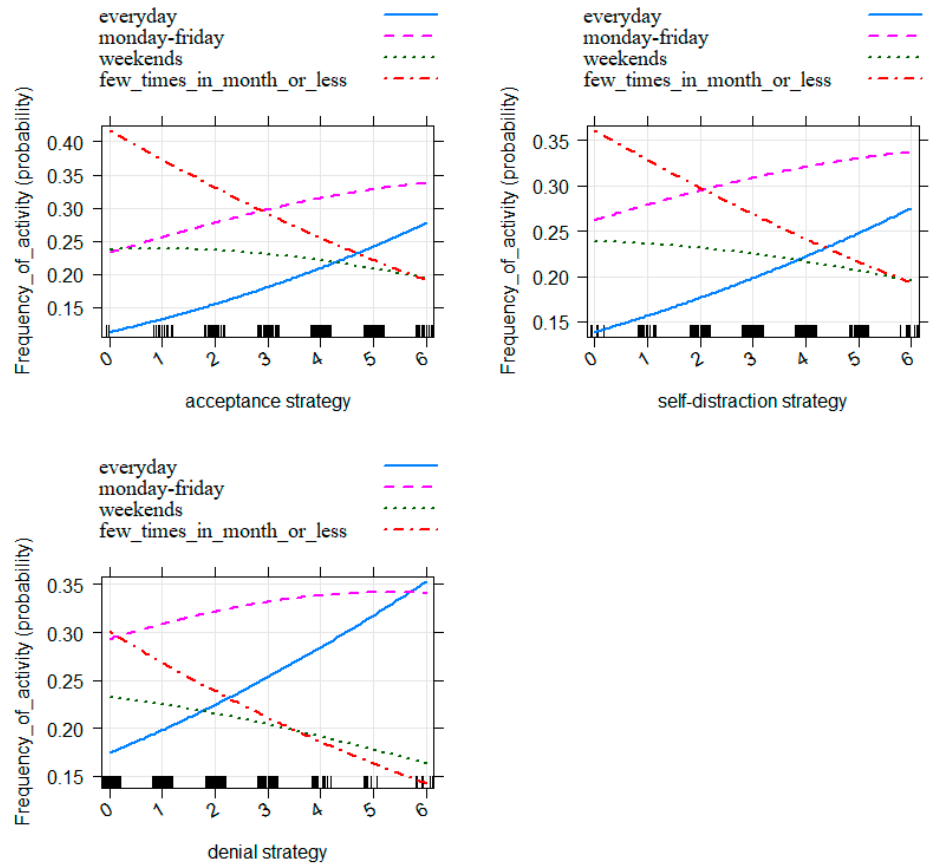
Figure 3. Frequency of recreational activity response for significant strategies from the Brief-COPE Inventory (14 strategies) (source: own computations).